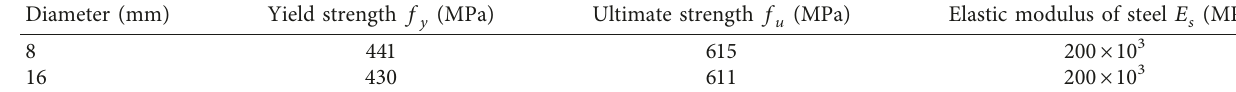
Table 5: Properties of longitudinal reinforcement and